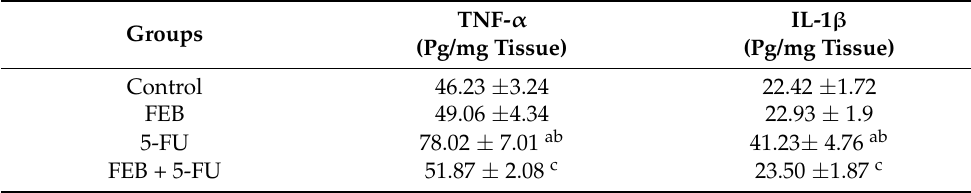
Table 3. Impact of FEB on inflammatory parameters (TNF- α and IL-1 β ) of 5-FU-induced parotid salivary gland injury in rats.